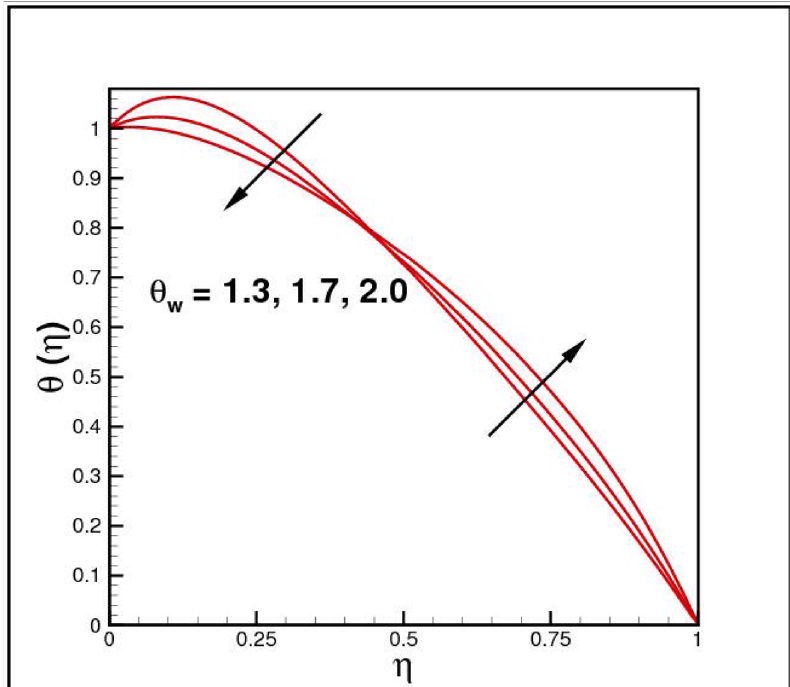
Figure 11. Impact of θ w on θ ( η ).